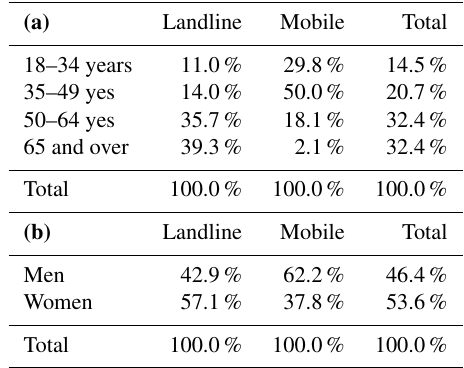
Table 3. (a) Response rate for age and telephone connection. (b) Response rate for gender and telephone connection.